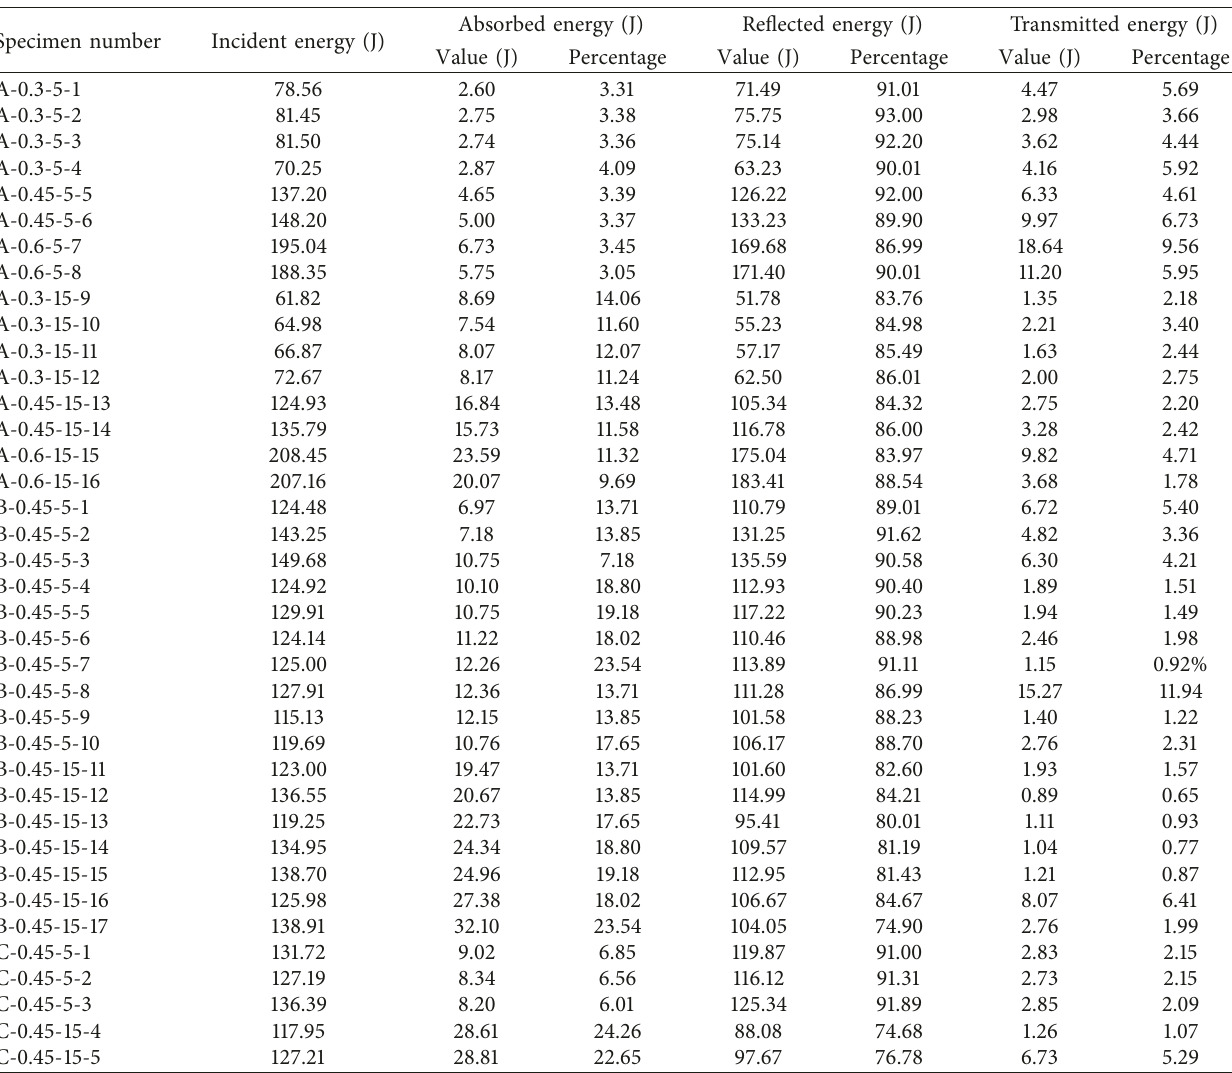
Table 4: Test results of the energy distribution of frozen soil. Specimen number